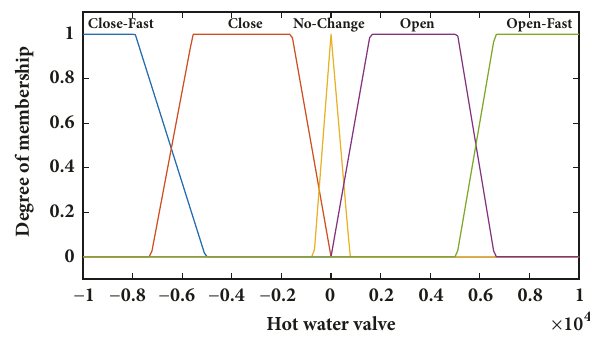
Figure 16: MFs of first output.